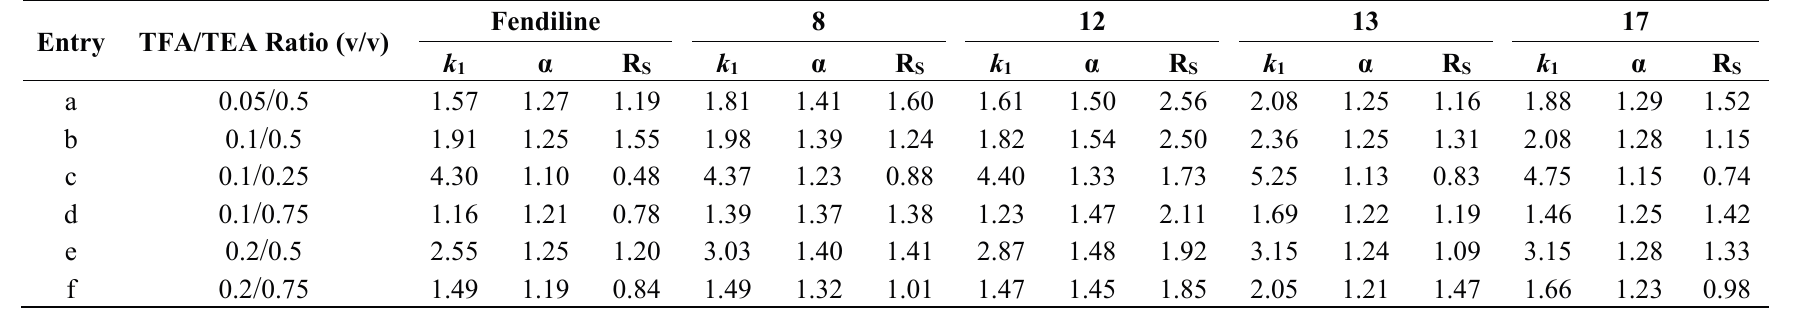
Table 2. Resolution of racemic fendiline and its analogues ( 8 , 12 , 13 and 17 ) on CSP 1 with the variation of the ratio of trifluoroacetic acetic acid (TFA)-triethylamine (TEA) in 80% methanol in acetonitrile as a mobile phase (MeOH-ACN-TFA-TEA, 80/20/x/y, v/v/v/v). Flow rate: 0.5 mL/min. Detection: 254 nm UV. Column temperature: 20 °C. k 1 : Retention factor of the first eluted enantiomer. α : Separation factor. R S :